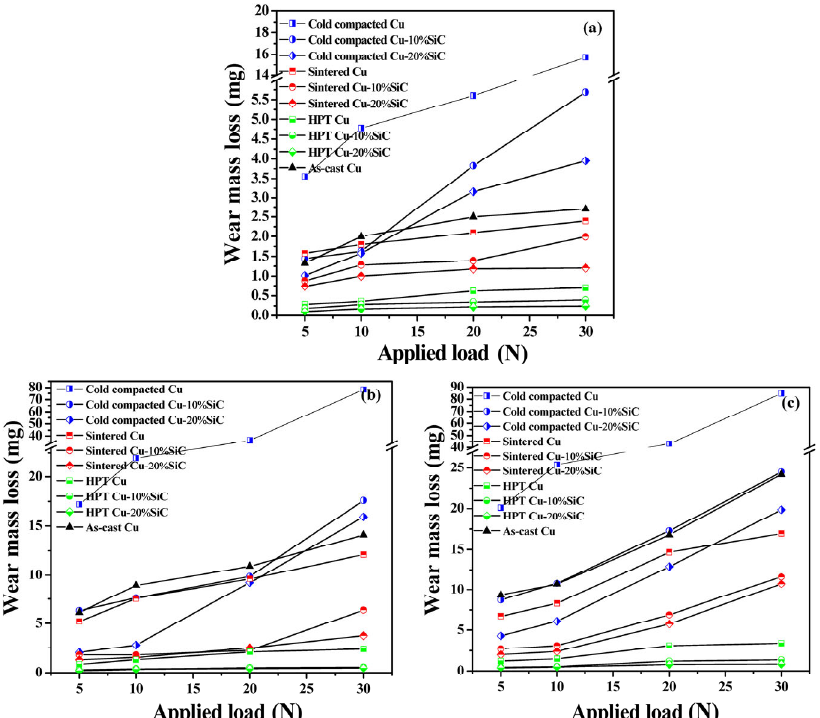
Fig. 2 The effect of the applied load on the wear mass loss of the as-cast Cu, cold compacted, sintered, and HPTed Cu and Cu-SiC samples under different sliding distances (a) 500, (b) 1,500, and (c) 2,500